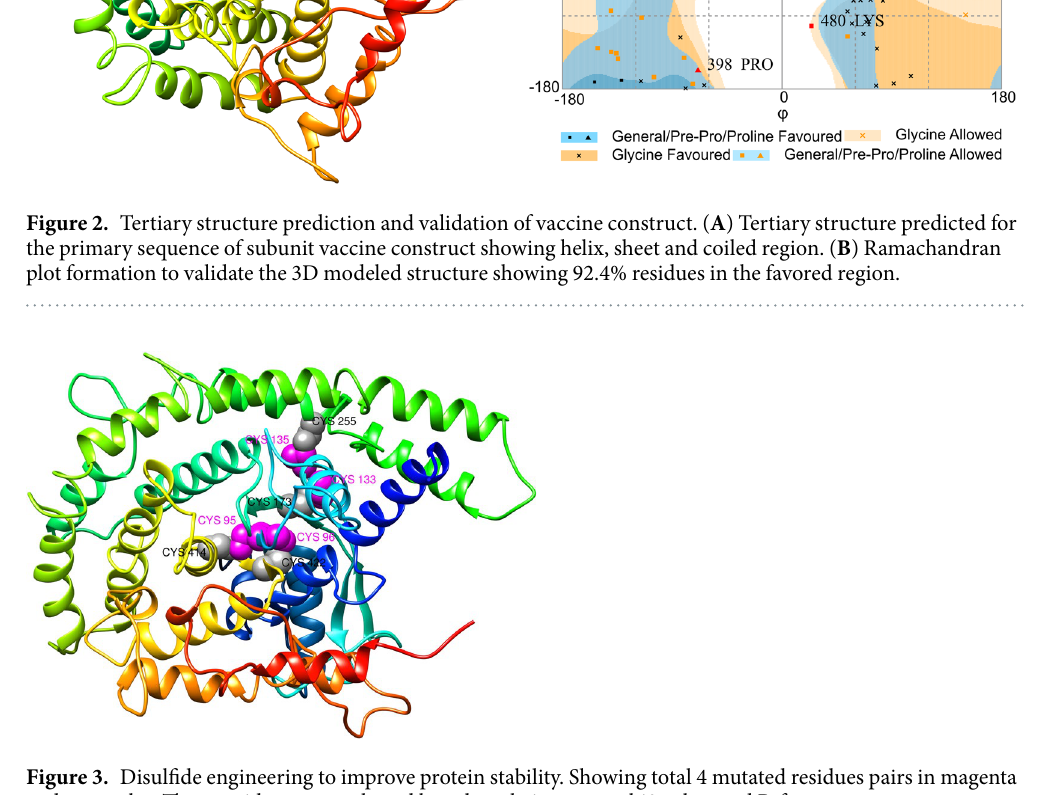
Figure 3. Disulfide engineering to improve protein stability. Showing total 4 mutated residues pairs in magenta and gray color. These residues were selected based on their energy, chi3 value, and